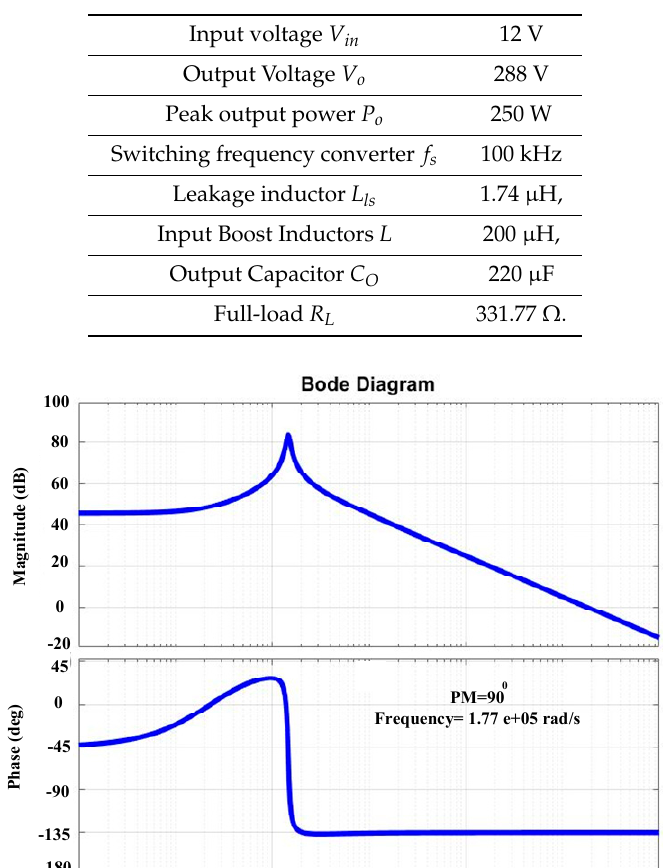
Figure 8. Bode plot of compensated control to input current transfer function: phase margin (PM) = 90 (cid:2868) at 177k rad/s.